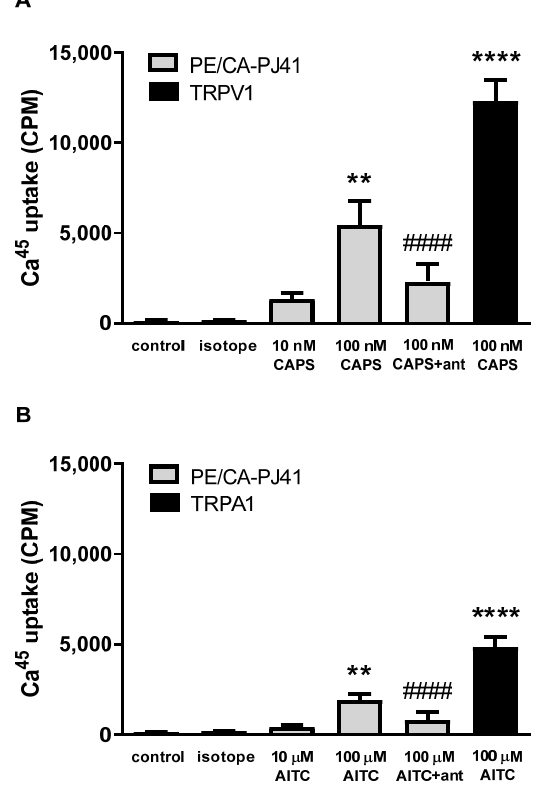
Figure 3. Effect of allyl-isothiocianate (AITC) and capsaicin (CAPS) on 45 Ca 2+ uptake (count per minute: CPM) of CHO cells expressing the cloned Transient Receptor Potential Ankyrin 1 (TRPA1, ( A )) and Vanilloid 1 (TRPV1, ( B )) receptors and PE/CA-PJ41 cells. CAPS and AITC responses were antagonized by capsazepine (10 µM) and HC-030031 (10 µM), respectively. 45 Ca 2+ accumulations are presented as a percentage of agonist control. Each column represents the mean ± SEM of n = 9, ** p < 0.01, **** p < 0.0001 (vs. control, one-way ANOVA, Dunnett’s post hoc test); #### p < 0.0001 (vs. 100 nM CAPS ( A ) or 100 µM AITC ( B ), one-way ANOVA, Dunnett’s post hoc test).